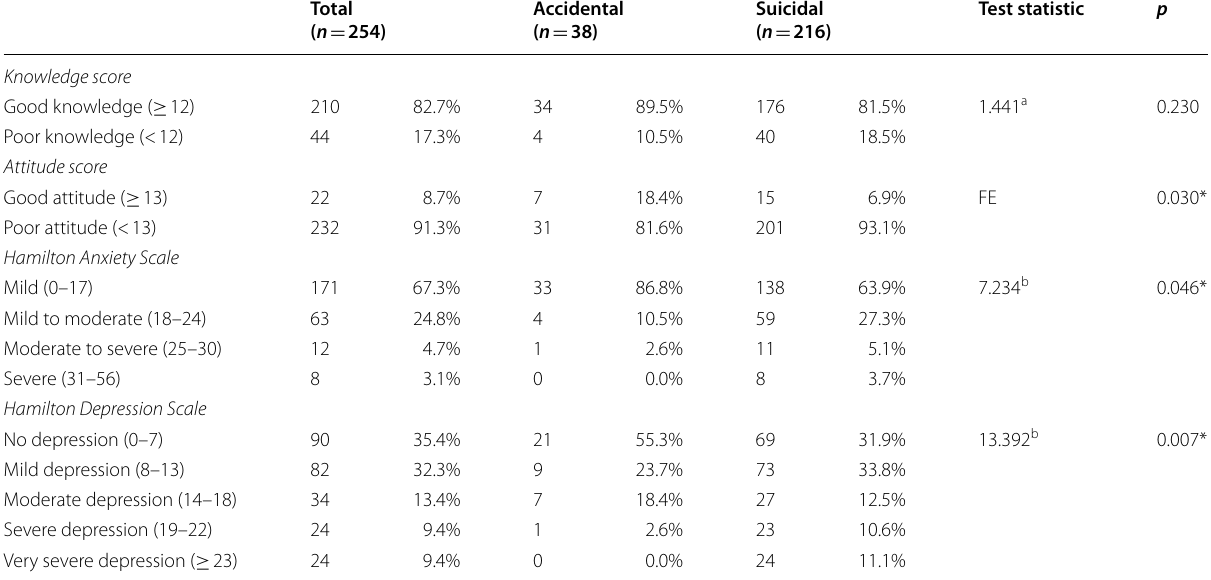
Table 2 Comparison of the score grading between the studied groups ( n